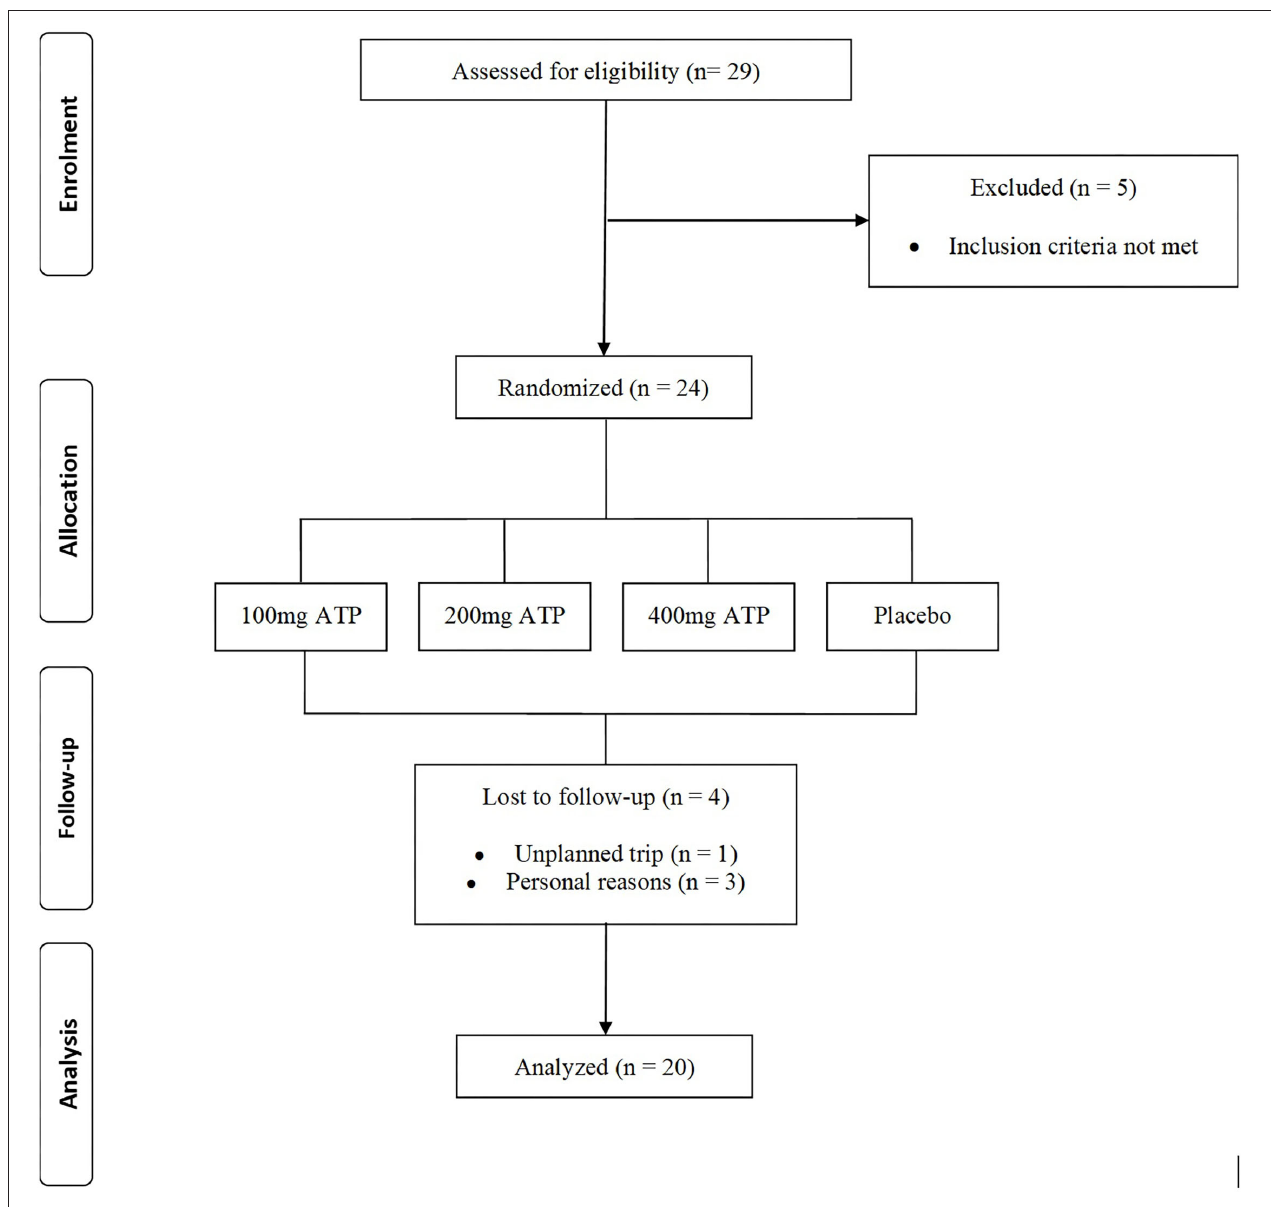
FIGURE 2 | CONSORT